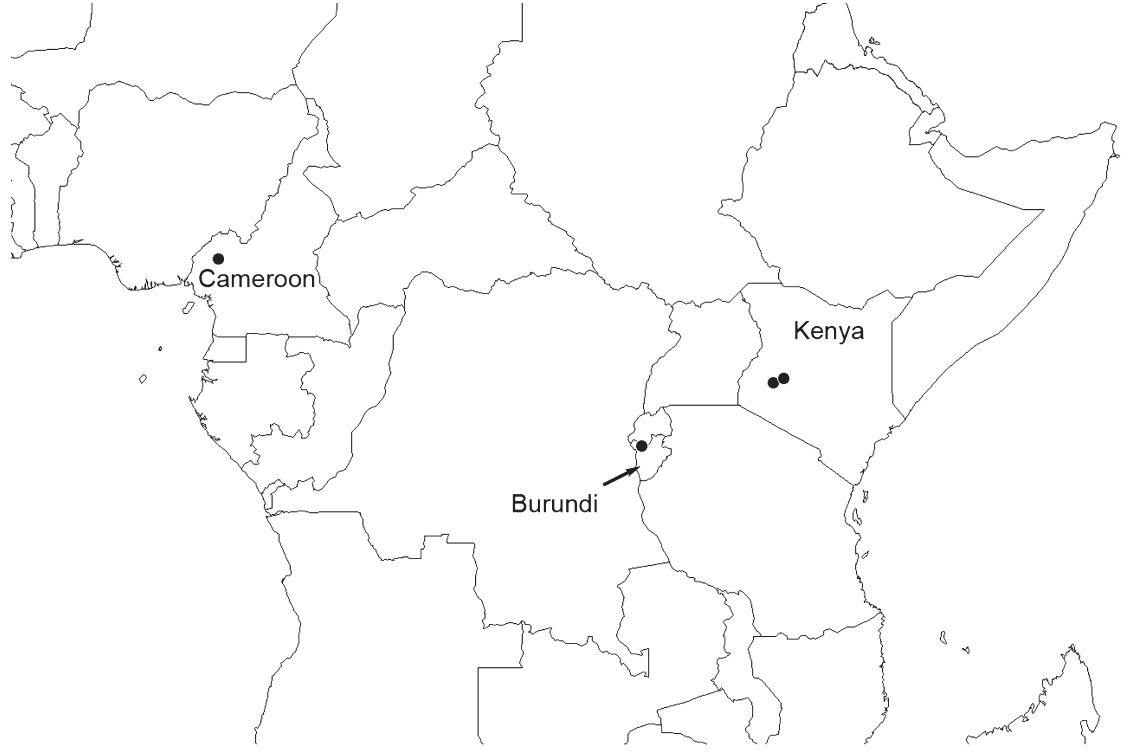
Fig. 6. distribution map of Pachygnatha procincta Bosmans & Bosselaers,